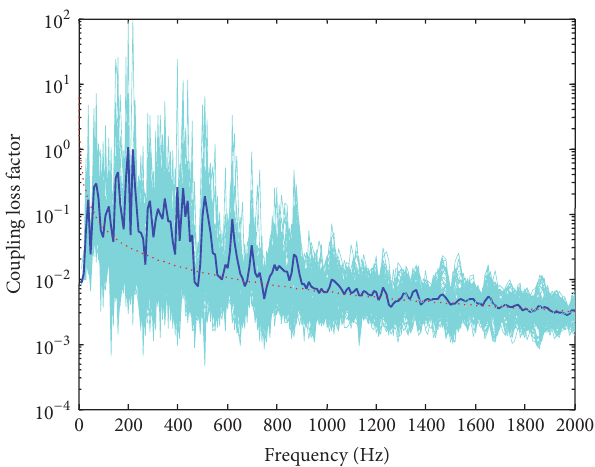
Figure 9: Comparison of 𝜂 12 when 𝑁 = 4 (narrowly-spaced): PIM simulations (real thin lines); ensemble average of the PIM solutions (thick real line); (43) (dotted